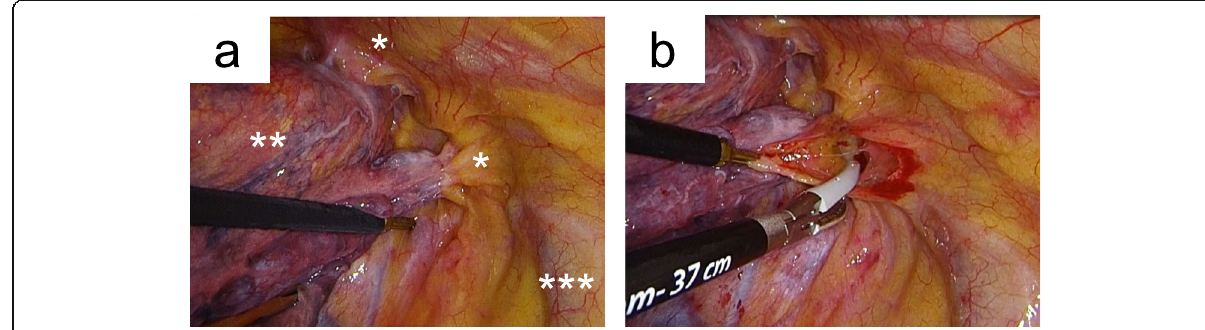
Fig. 2 Thoracoscopic views of the right superior sulcus. a Partial parietal pleural invasion of the apex chest wall. b Parietal pleurectomy at the site of tumor invasion and additional resection of the extra parietal pleural fatty tissue was performed by complete VATS. *The site of tumor invasion